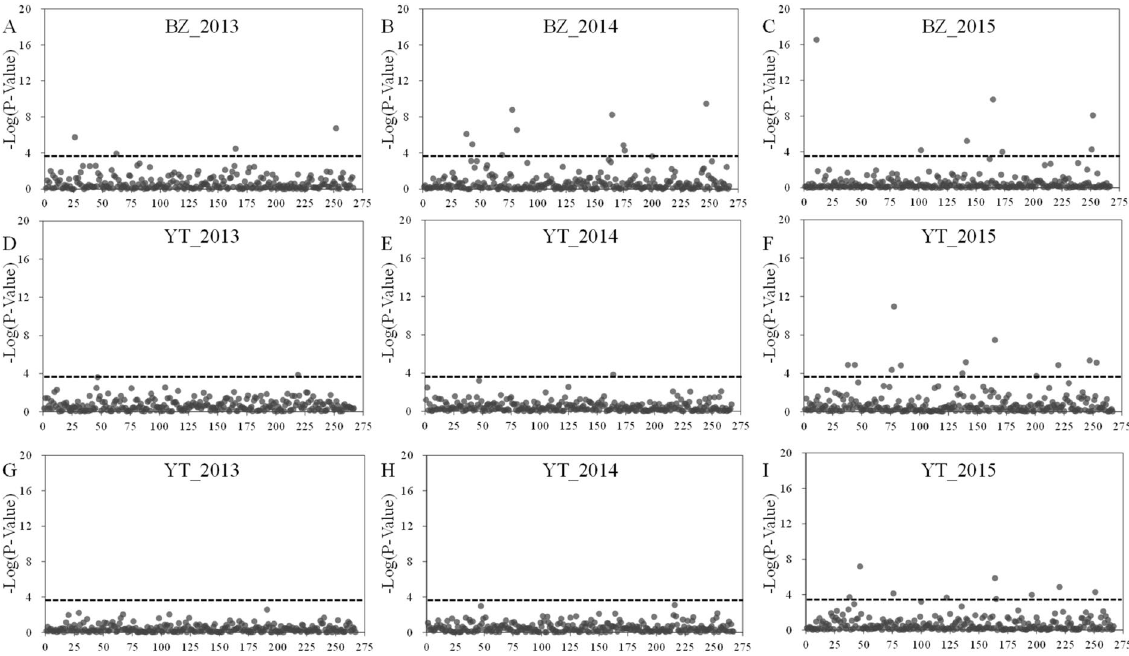
Figure 4. Manhattan plot of –Log 10 P values of the marker-trait association for frost tolerance in pea with nine different trait datasets at three locations and three growing seasons using mixed linear model (MLM + Q + K). Threshold after sequential Bonferroni correction at 3.7 was indicated with dashed lines.